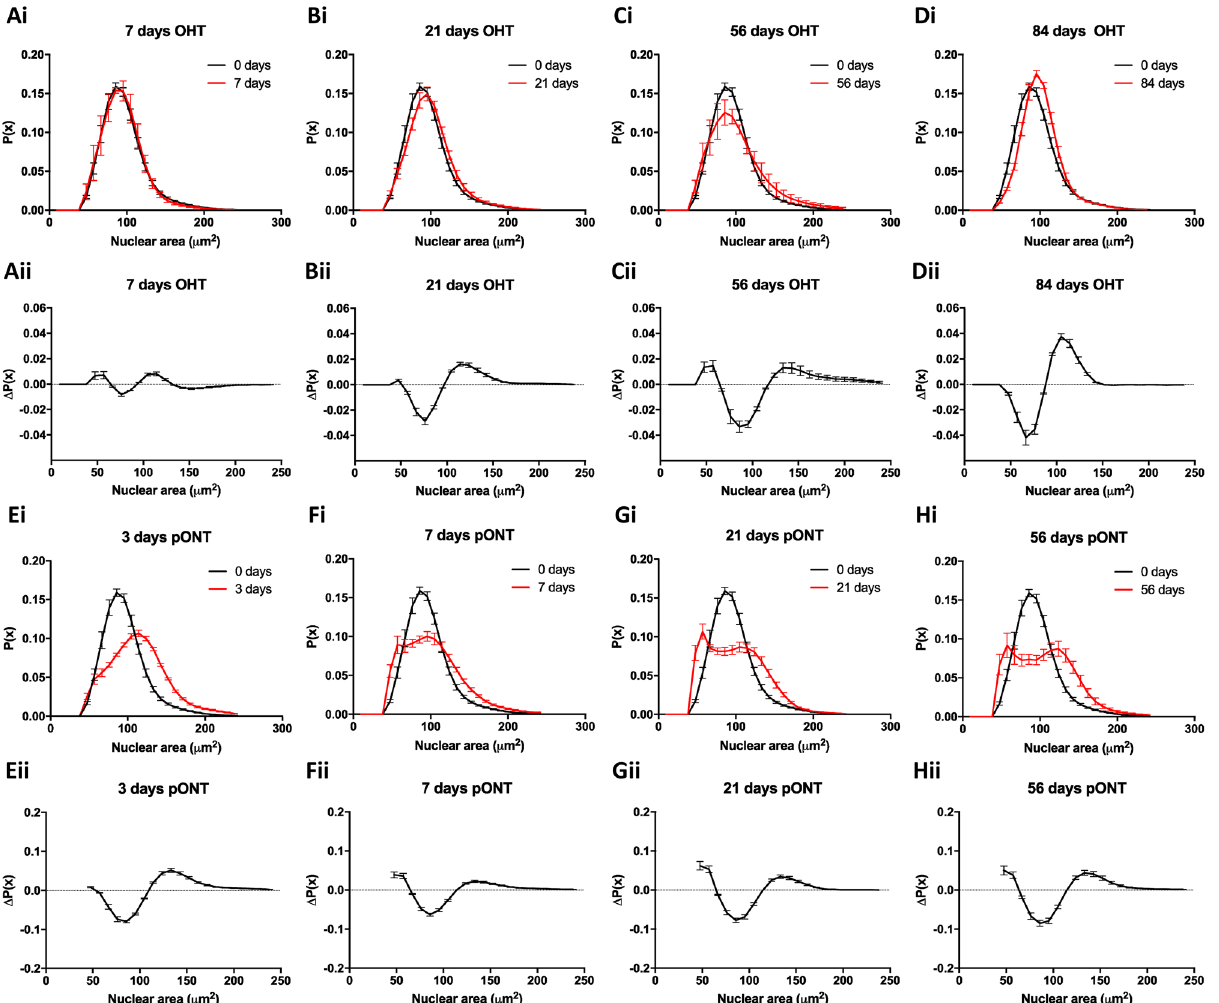
Figure 3. ( A – D ) Assessment of RGC nucleus size probability distribution functions (i), and difference versus control condition (ii), over the natural history of the OHT model. ( E – H ) Assessment of RGC nucleus size probability distribution functions in the pONT model (i), and difference versus control condition (ii), over the natural history of the pONT model. Mean ±